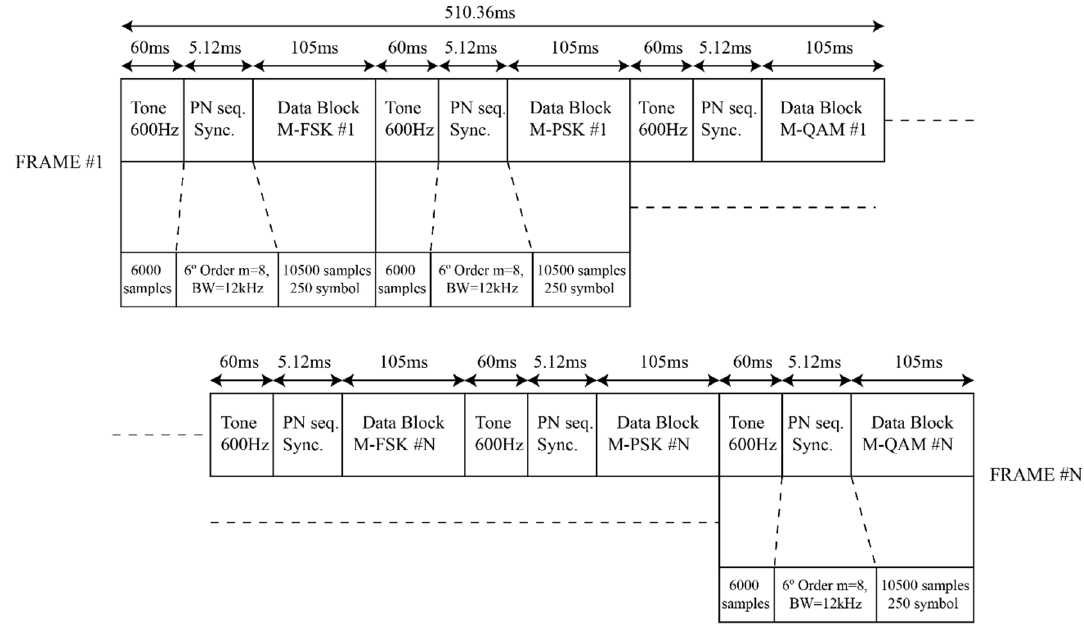
Figure 5. Data frame design [27].